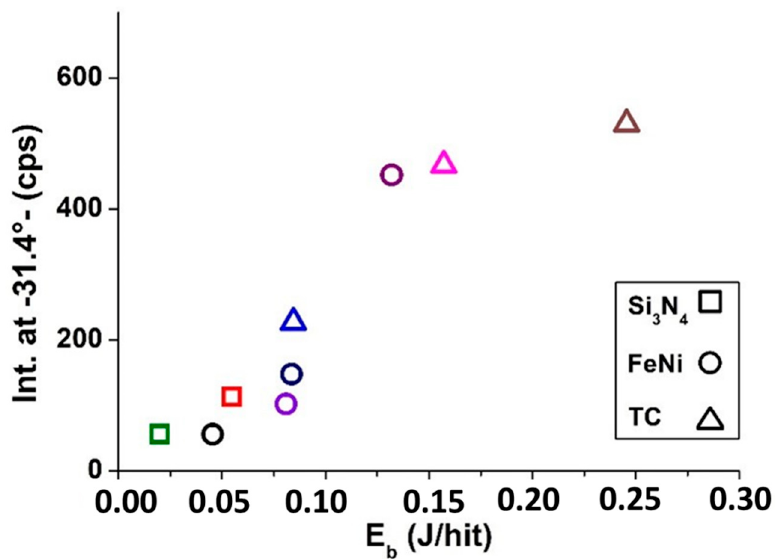
Figure 3. XRD measurement-based (BaTiO 3 peak intensity at 2 θ 31.4°,) milling-map of BaTiO 3 samples in different grinding vessels.